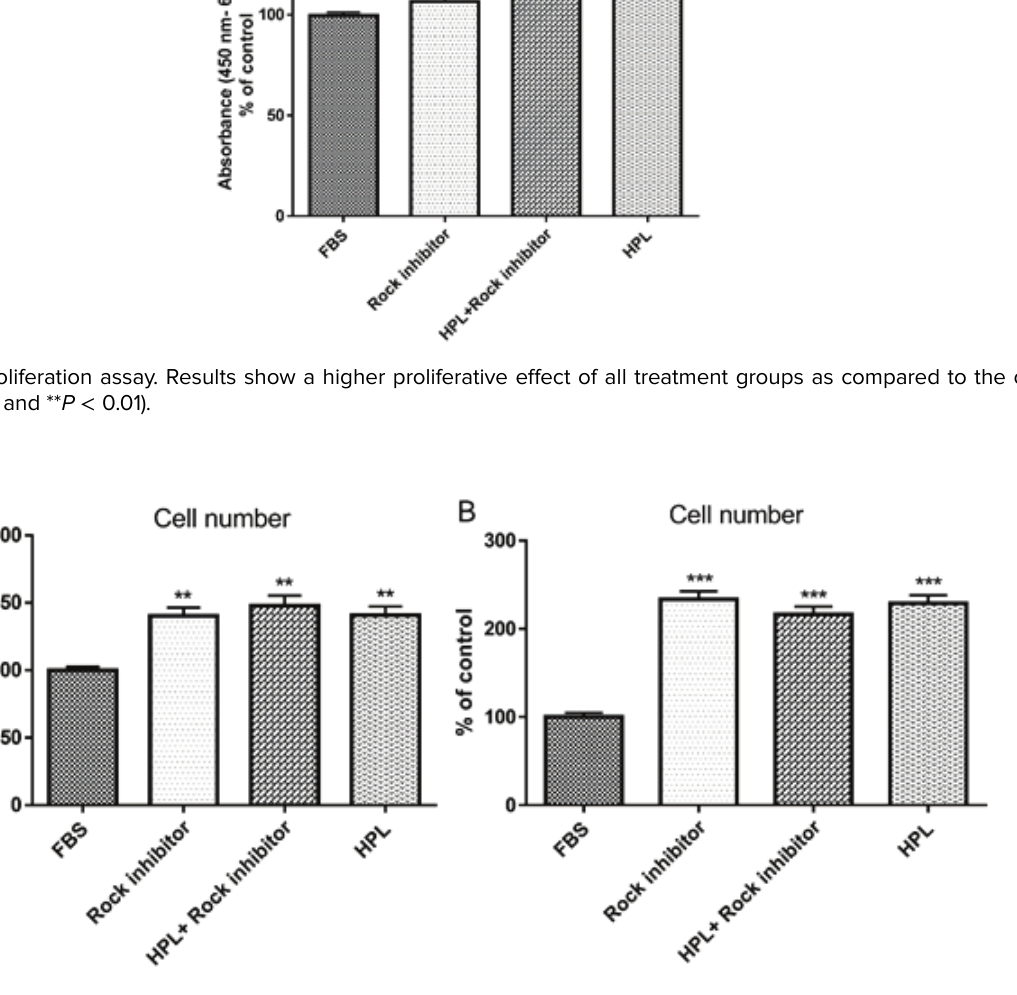
Figure 2. The numbers of HCECs after (A) one and (B) five days of treatments. As illustrated, the numbers of HCECs treated with HPL, combination of HPL and Y-27632 ROCK inhibitor, and Y-27632 ROCK inhibitor alone was significantly higher than FBS (control)-treated group (** P < 0.01 and *** P <